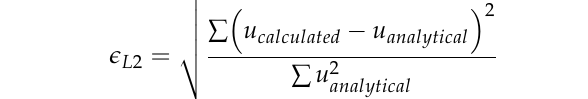
13 of 21 Figure 10. Configuration of two ‐ phase Poiseuille flow test. In the first test group, both phases were Newtonian fluids. The dynamic viscosity of phase A was set as (cid:2020) (cid:3002) = 1.0 Pa·s. In the different test cases, the dynamic viscosity of phase B was varied from 1.0 to 0.1 Pa·s. Bird et al. [57] proposed an analytical solution for the velocity profile of two Newtonian fluids in the steady state. The calculated velocity profiles were compared with the analytical solutions in Fig ‐ ure 11. The velocity profiles of both phases formed a parabolic shape owing to the no ‐ slip boundary condition applied at the fixed ghost particles (Figure 11). The velocity transi ‐ tion points of all test cases were located at the phase interface (Figure 11). Although the errors increased slightly with the increasing dynamic viscosity ratio between the two phases, there was still good agreement between the calculated velocity profiles and ana ‐ lytical velocity profiles. Figure 11. Velocity profiles of two ‐ phase Newtonian Poiseuille flow tests.